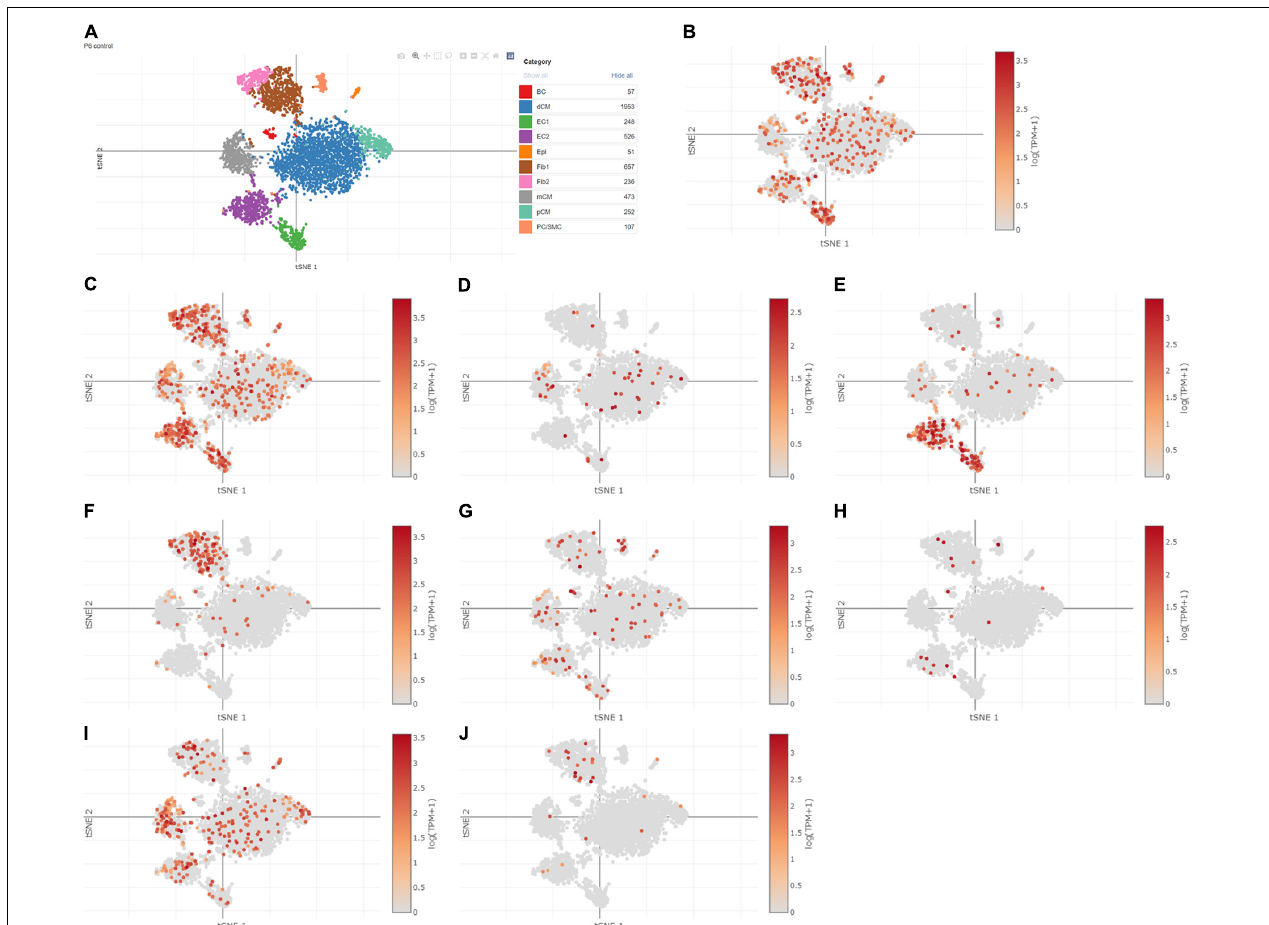
FIGURE 11 | The hub genes were highly expressed in the postnatal mammalian heart. (A) The overall clustering of cells in the postnatal mammalian heart. (B–J) The hub genes were validated to be highly expressed in the postnatal mammalian heart, such as IL-6 (B) , JUN (C) , NQO1 (D) , NOS3 (E) , LEPR (F) , NAMPT (G) , CDKN2A (H) , CDKN1A (I) , and Snai1 (J) , while there was no PTGS2 expression in the postnatal mammalian heart.